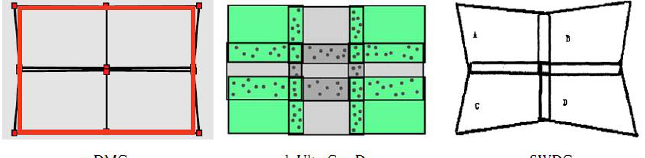
Figure 2. Mechanical structures of DMC,UCD,SWDC cameras